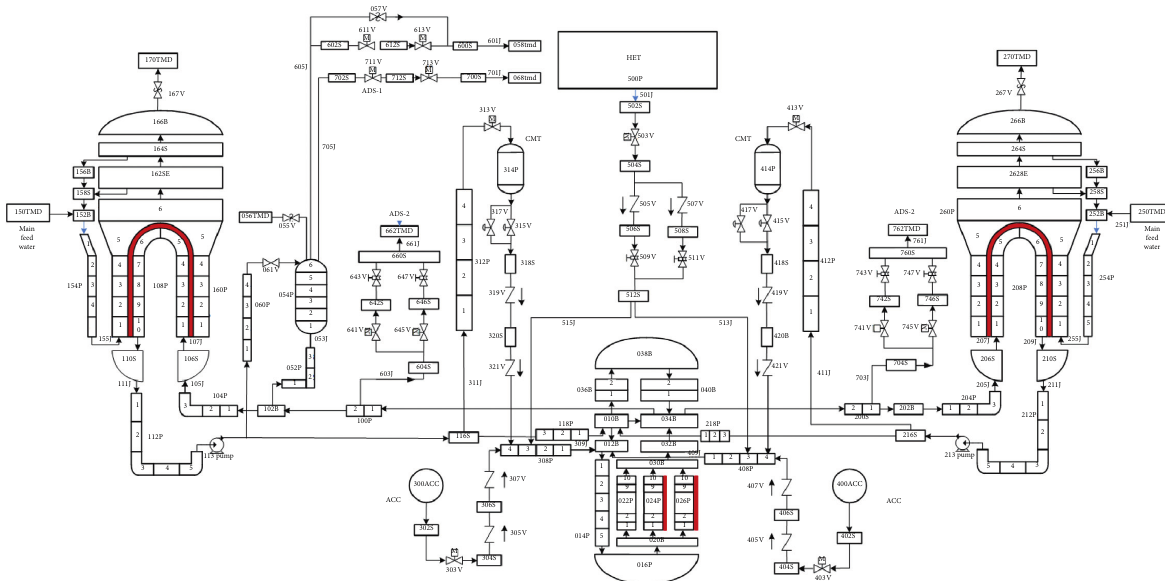
Figure 2: RELAP5 nodalization scheme.